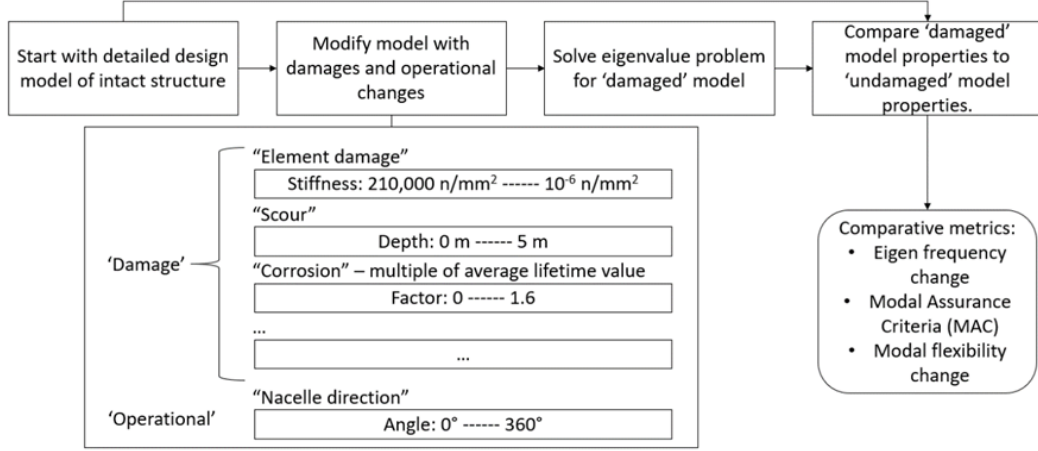
Figure 1. Diagram of damage process used to map damages implemented in a structural model with structural response caused by a change in the structure.